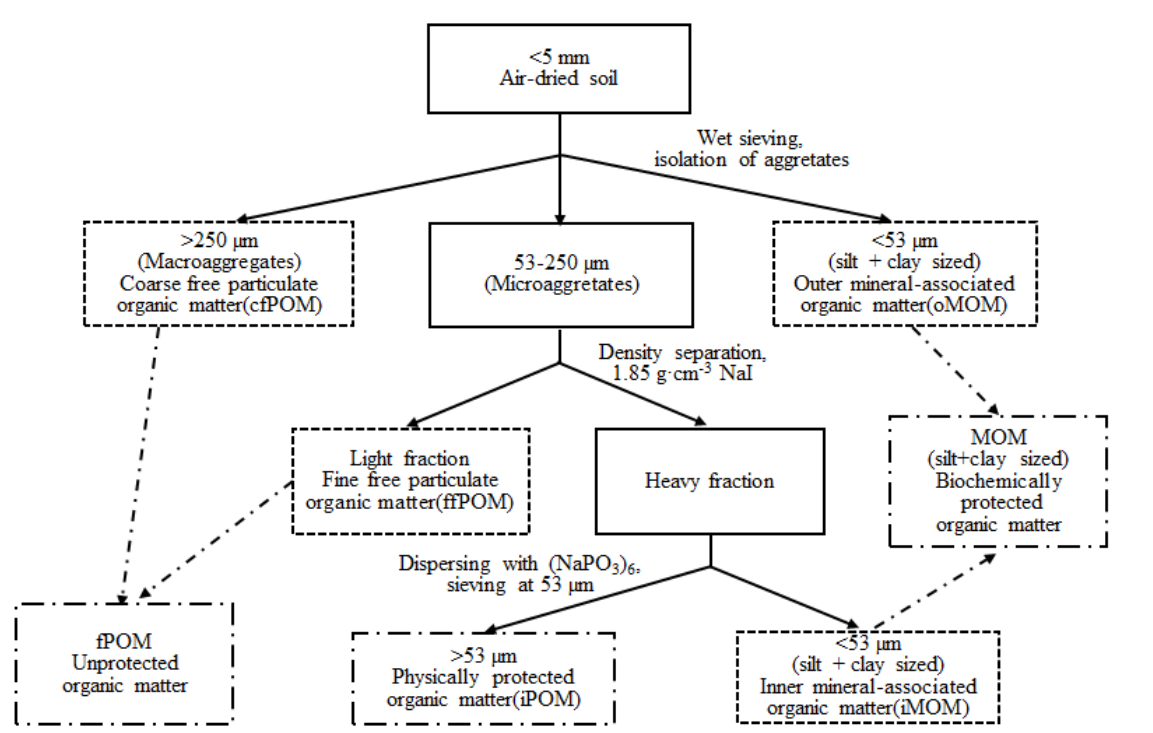
Figure A2. Schematic of the applied physical fractionation procedure for the isolation of coarse-free particulate organic matter (cfPOM, unprotected organic matter), fine free particulate organic matter (ffPOM, unprotected organic matter), particulate organic matter inner microaggregate (iPOM, physically protected organic matter), mineral-associated organic matter inner microaggregate (iMOM, biochemically protected organic matter), and mineral-associated organic matter outer fraction (oMOM, biochemically protected organic matter). The percentage of each fraction in the total soil (PEF) was calculated by weight.